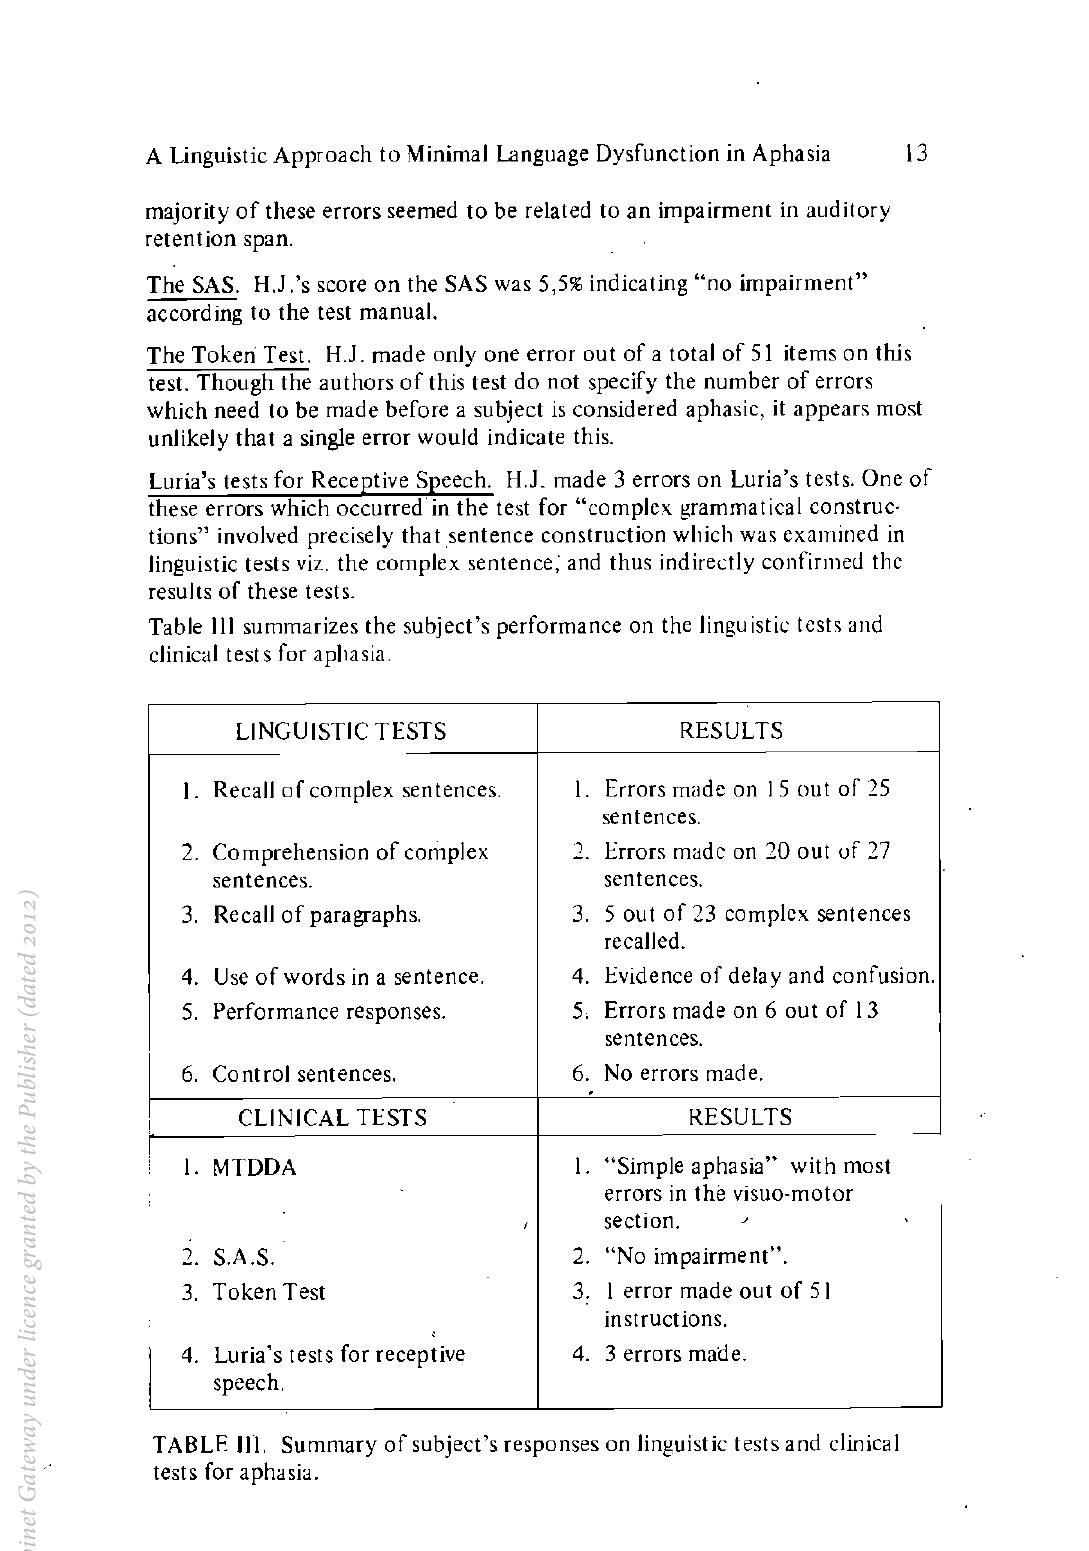
TABLE 111. Summary of subject's responses on linguistic tests and clinical tests for aphasia.